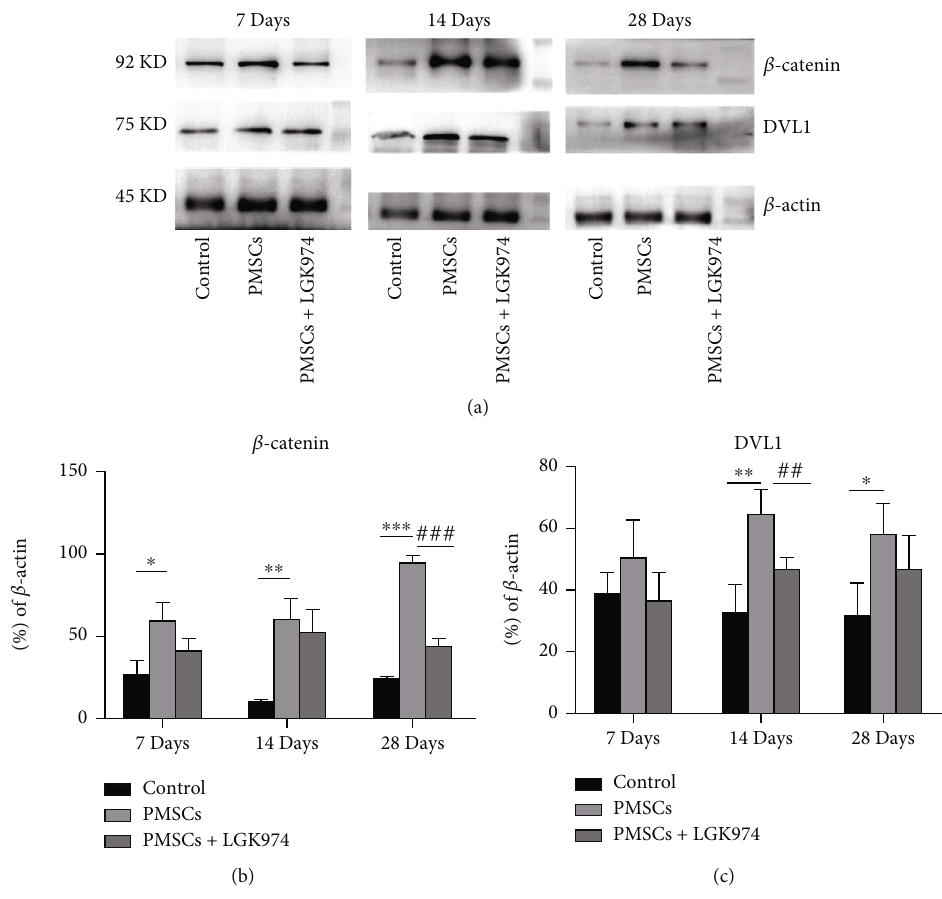
Figure 8: E ff ects of stem cell transplantation and Wnt signaling pathway inhibition on nerve repairing. (a) PMSC treatment activates β - catenin on 28 days. There was more increase in DVL1 in the PMSC group on 14 days. PMSCs decrease Bax on 7, 14, and 28 days. LGK974 inhibited β -catenin on 28 days and decreased DVL1 on 14 days. (b, c) Quanti fi cation of western blot bands of DVL1 and β - catenin was summarized. Data were expressed as the mean ± SEM . n = 3 independent experiment; ∗ PMSC group vs. control group, P < 0 : 05 ; # PMSC group vs. PMSC+LGK974 group, P < 0 : 05 . All samples were taken from the sciatic